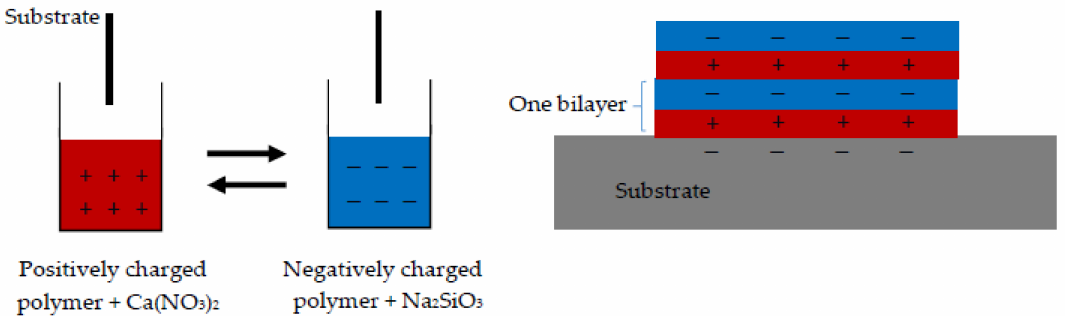
Figure 2. Schematic showing the layer-by-layer (LBL) fabrication of calcium-silicate-hydrate (CSH)/polymer